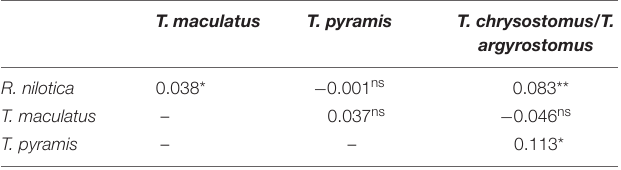
TABLE 3 | Analysis of Similarity test (ANOSIM), pairwise R values and statistical significance levels for habitat variables relating to the density of different gastropod species.